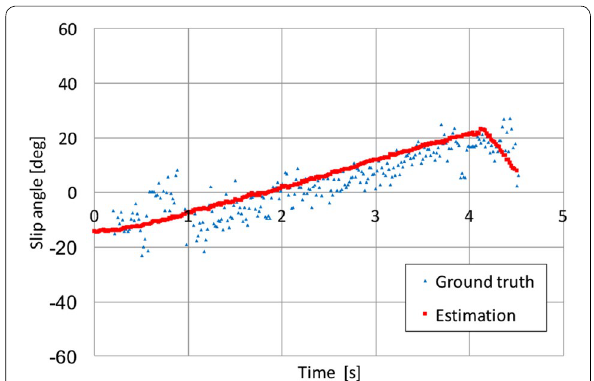
Fig. 14 Result of slip angle estimation